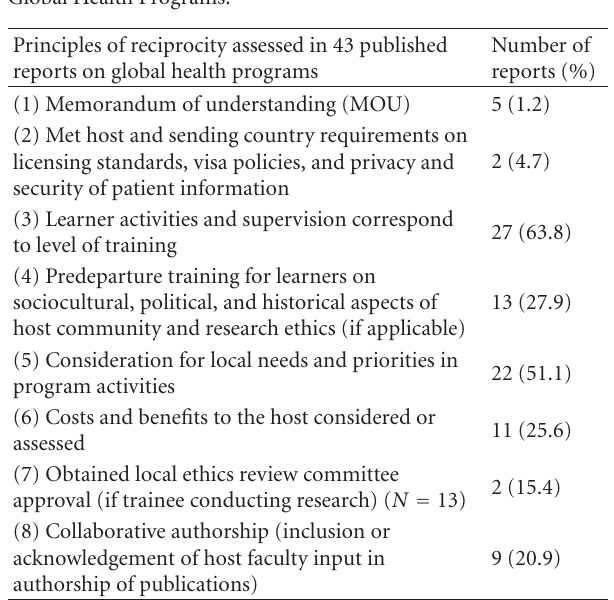
Table 2: Principles of Reciprocity in Published Descriptions of Global Health Programs.